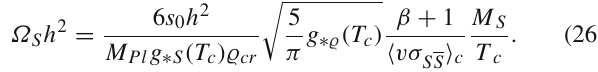
Hadronic physics indicates 5 (cid:3) x c ≡ M S / T c (cid:3) 10,